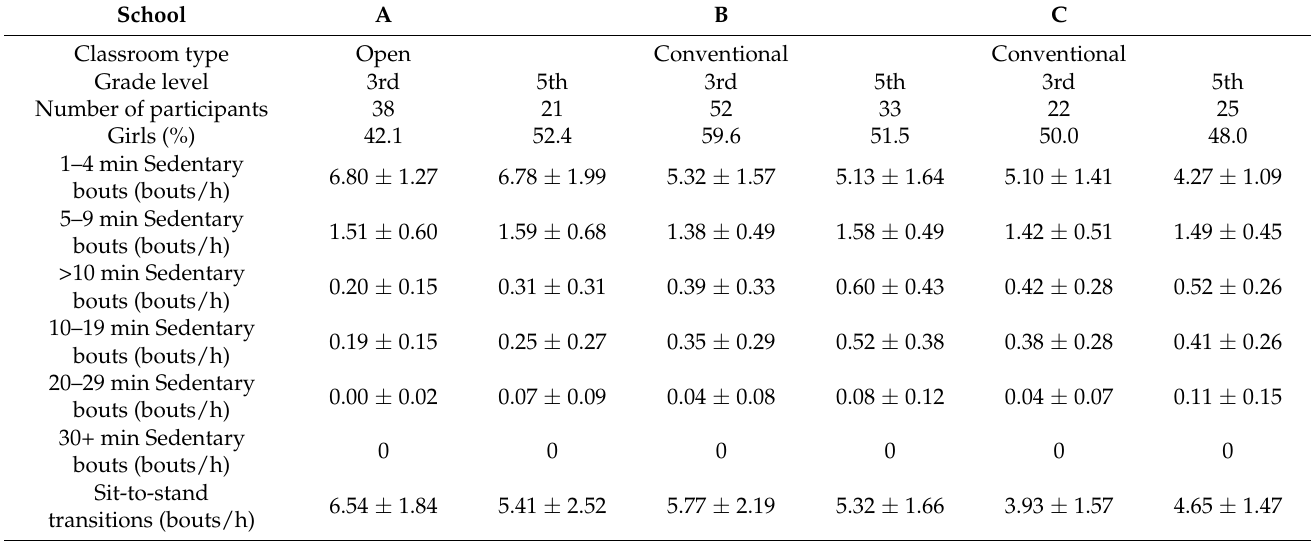
Table 1. Results of the sedentary behavior assessments by school and grade level.